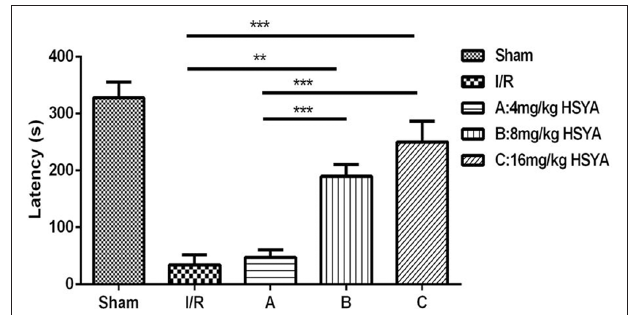
FIGURE 4 | Neuroprotective effects of HSYA on passive avoidance test (PAT). The values are shown as means ± SEM. Significant difference between MCAO group vs. 8 mg/kg HSYA ( ∗∗ P < 0.01) and 16 mg/kg HSYA groups ( ∗∗∗ P < 0.001), 4 mg/kg HSYA vs. 8 mg/kg HSYA ( ∗∗∗ P < 0.001) and 16 mg/kg HSYA groups ( ∗∗∗ P < 0.001) in latency.